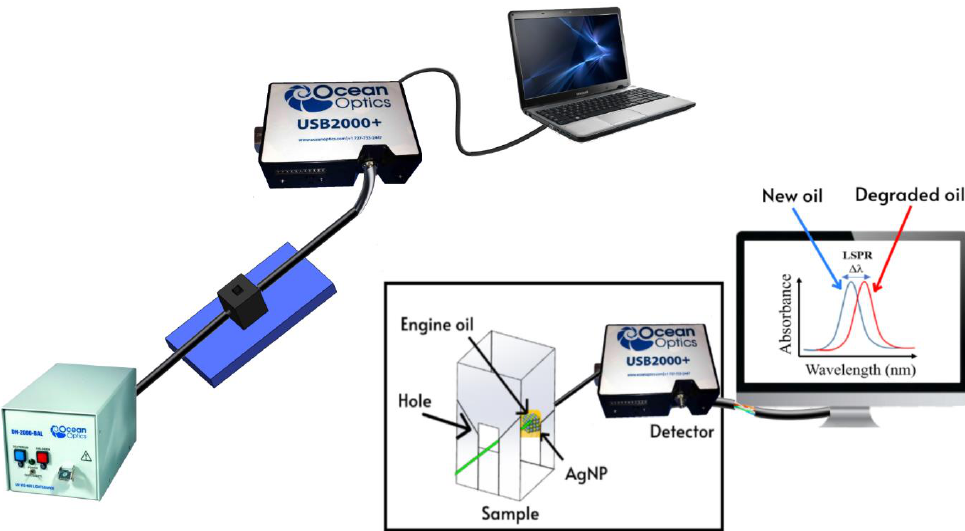
Figure 2. Experimental setup of the LSPR sensing technique.